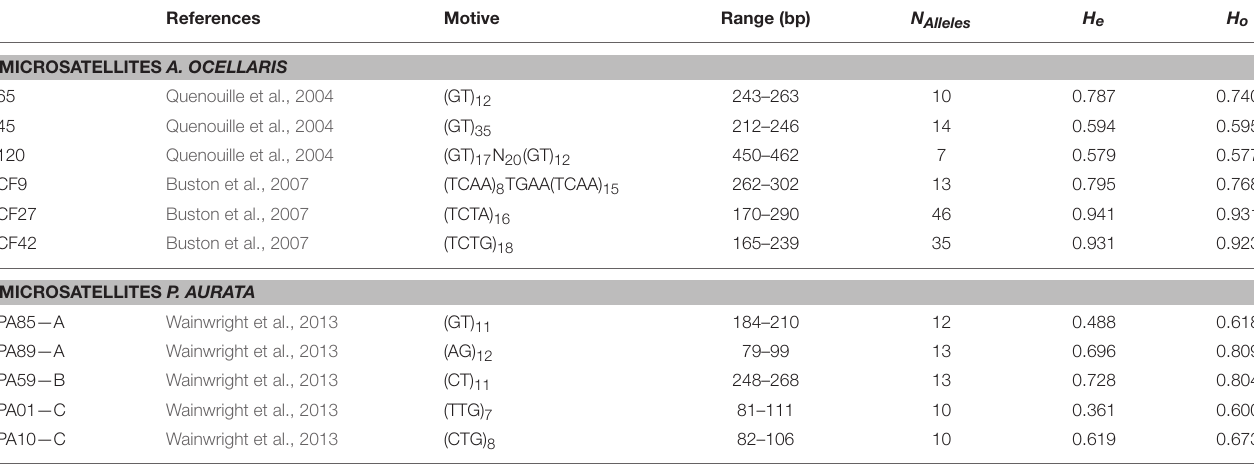
TABLE 3 | Microsatellite markers used for the population genetic analysis of the clown anemonefish, Amphiprion ocellaris , and the sea squirt, Polycarpa aurata , in this